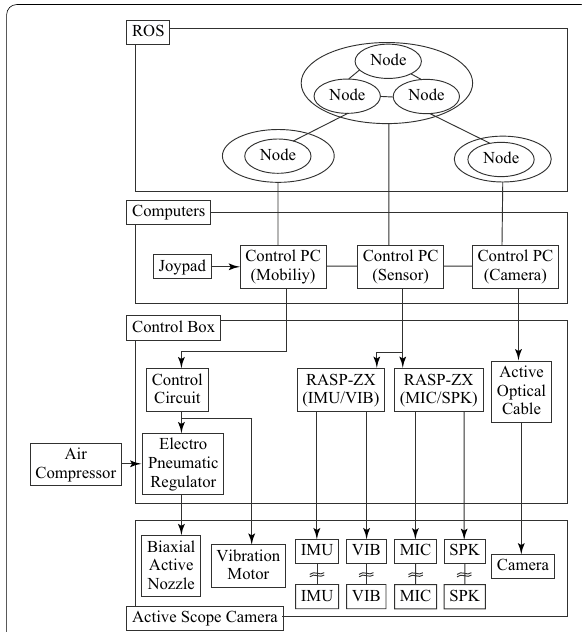
Fig. 8 System overview of the active scope camera with sensory